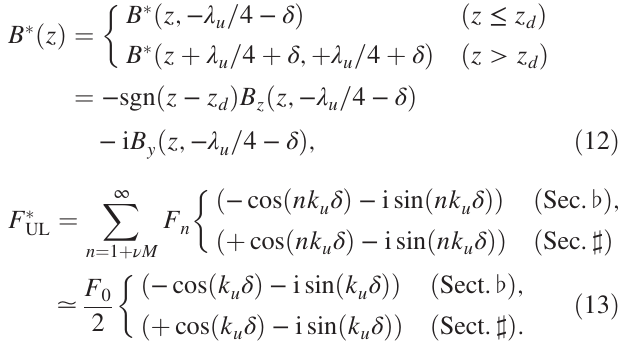
. The symbol ♭ indicates that the upper magnets are displaced by Δ u